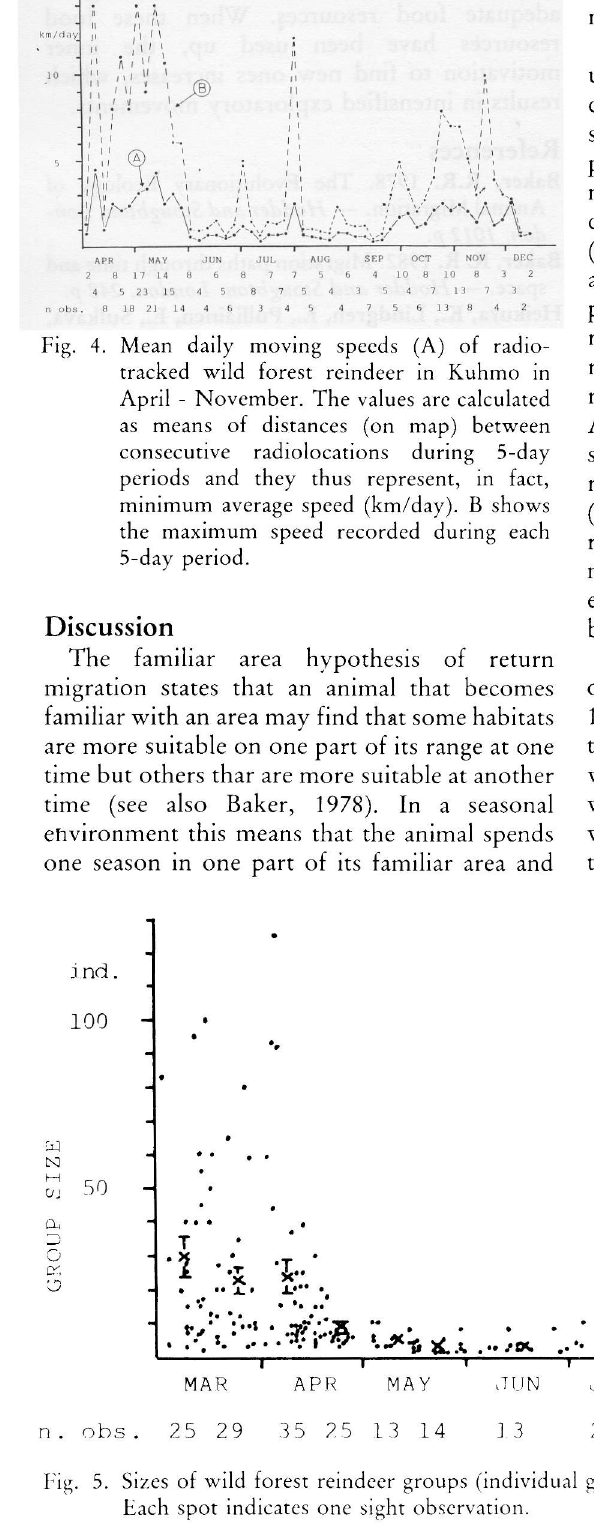
Fig. 5. Sizes of wild forest reindeer groups (individual groups) seen in Kuhmo in March - November 1984. Each spot indicates one sight